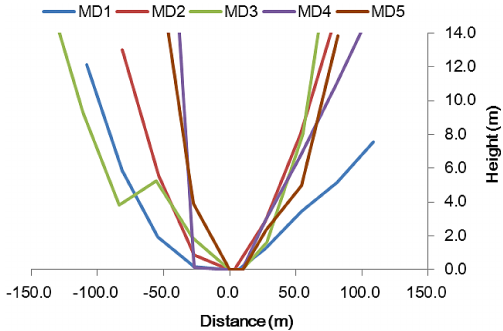
Fig.5. Time-discharge curve of Guangxieco Lake Outburst (the data is from Li and You, Figure 5. Time–discharge curve of Guangxieco Lake outburst (the data are from Li and You, 1992). Figure 6. The cross-sectional profiles from section MD1 to section 1992) MD5.